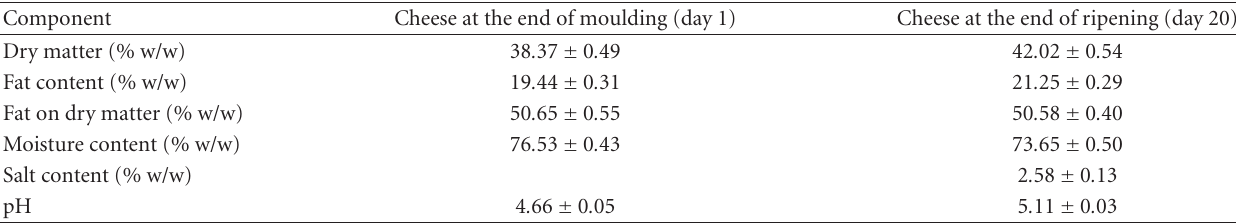
Table 3: Physicochemical properties of Camembert cheeses.